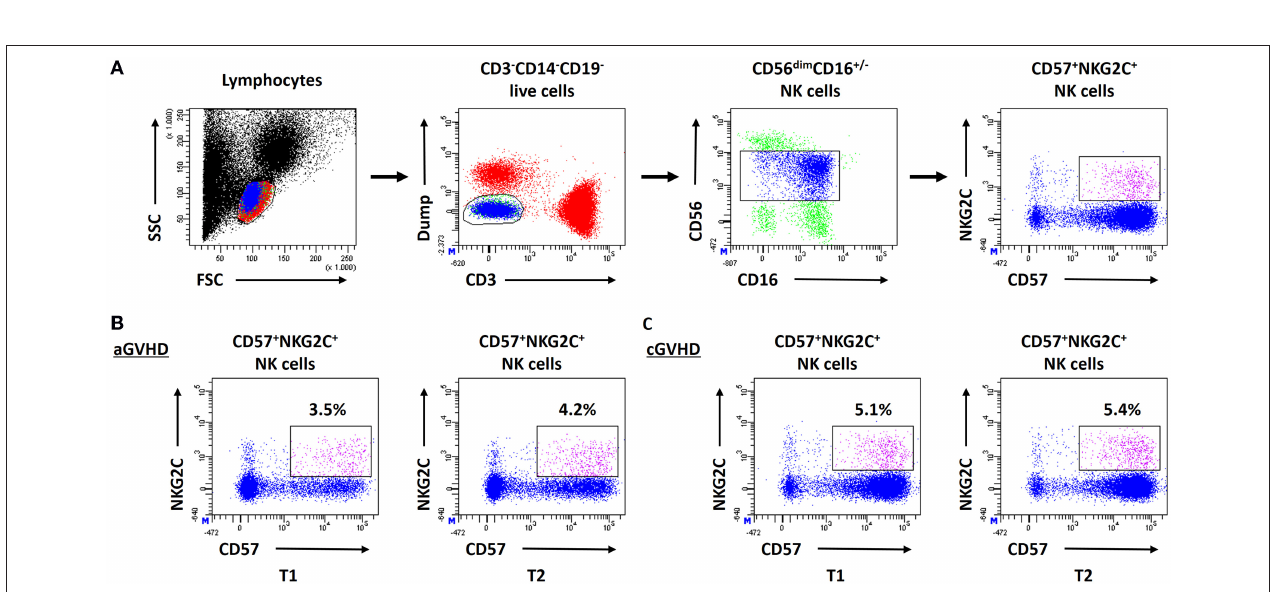
FIGURE 5 | NK cells (C) has been observed in aGVHD patient with response under ECP therapy. (D) The effect of ECP therapy has not been observed on CD56 bri tolerant NK cells. The responder group includes the patients with CR ( n = 3, excluding patient #8 due to the limited cell number of sample) and patients with PR ( n = 8). The non-responder group includes the patients with NR ( n = 1, excluding patient #5 due to the limited cell number of sample) and patients with ST ( n = 2). * p < 0.05.